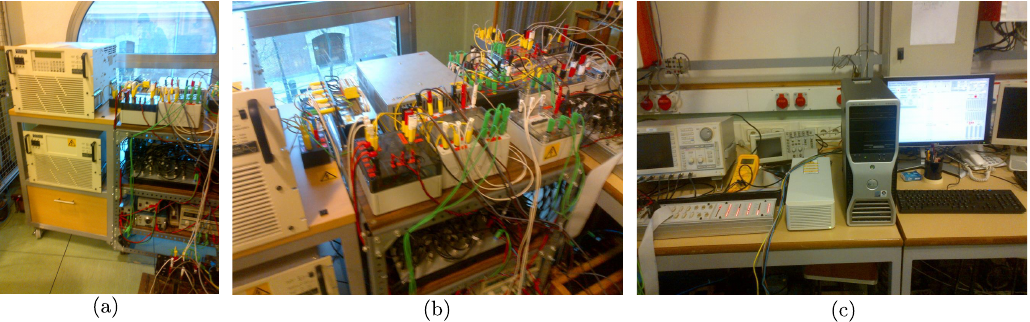
Figure 6. Photographs of the experimental platform. ( a ) Programmable voltage source, ( b ) (left) DVR and connection elements and (right) loads, and ( c ) dSpace platform, oscilloscopes, and external